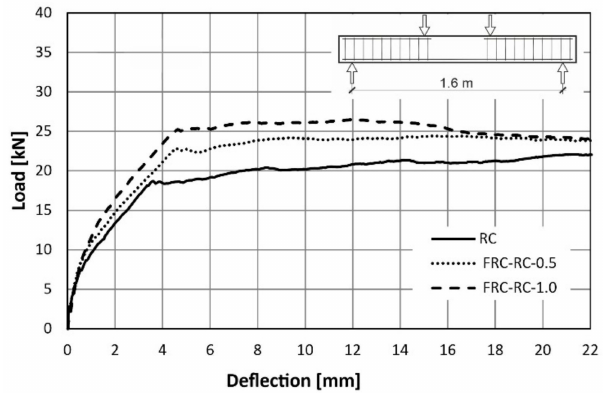
Figure 18. Comparison of the load-deflection curves from flexural tests on FRC-RC